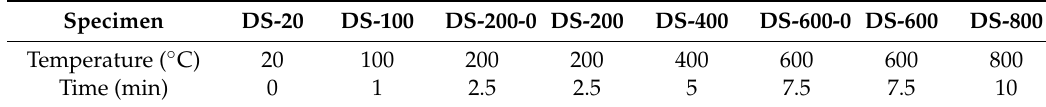
Table 4. Specimen heating parameters.